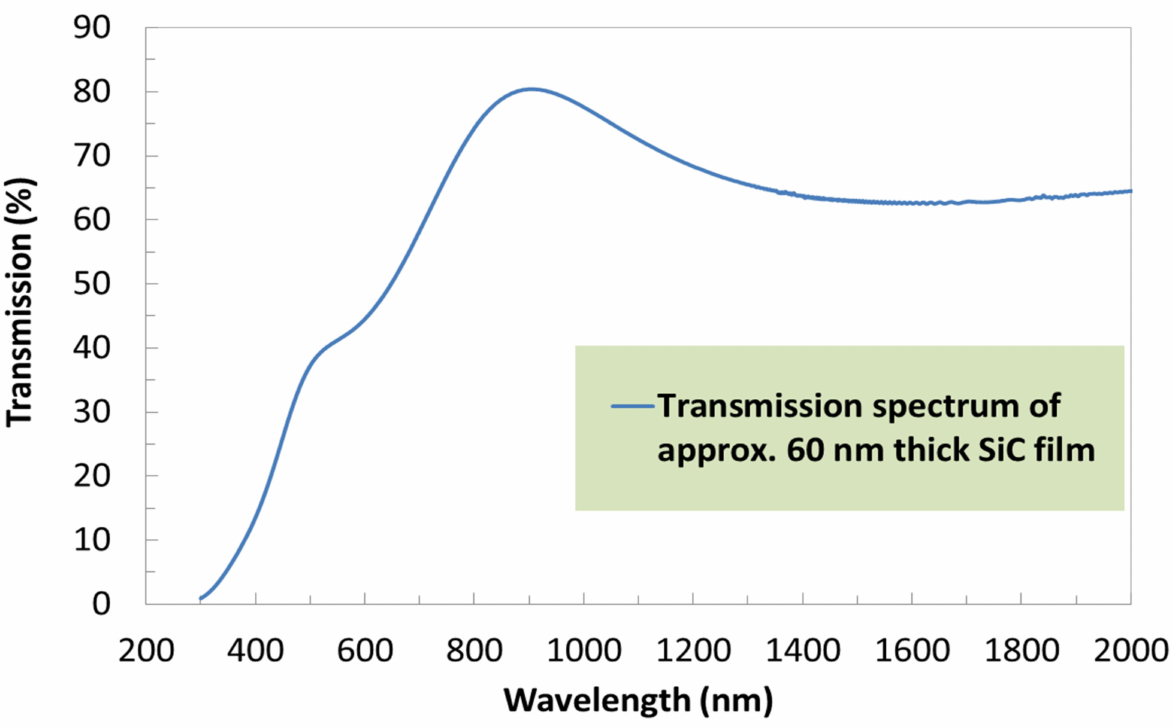
Figure 3. Optical transmission spectrum of an amorphous SiC layer prepared by using RF magnetron sputtering